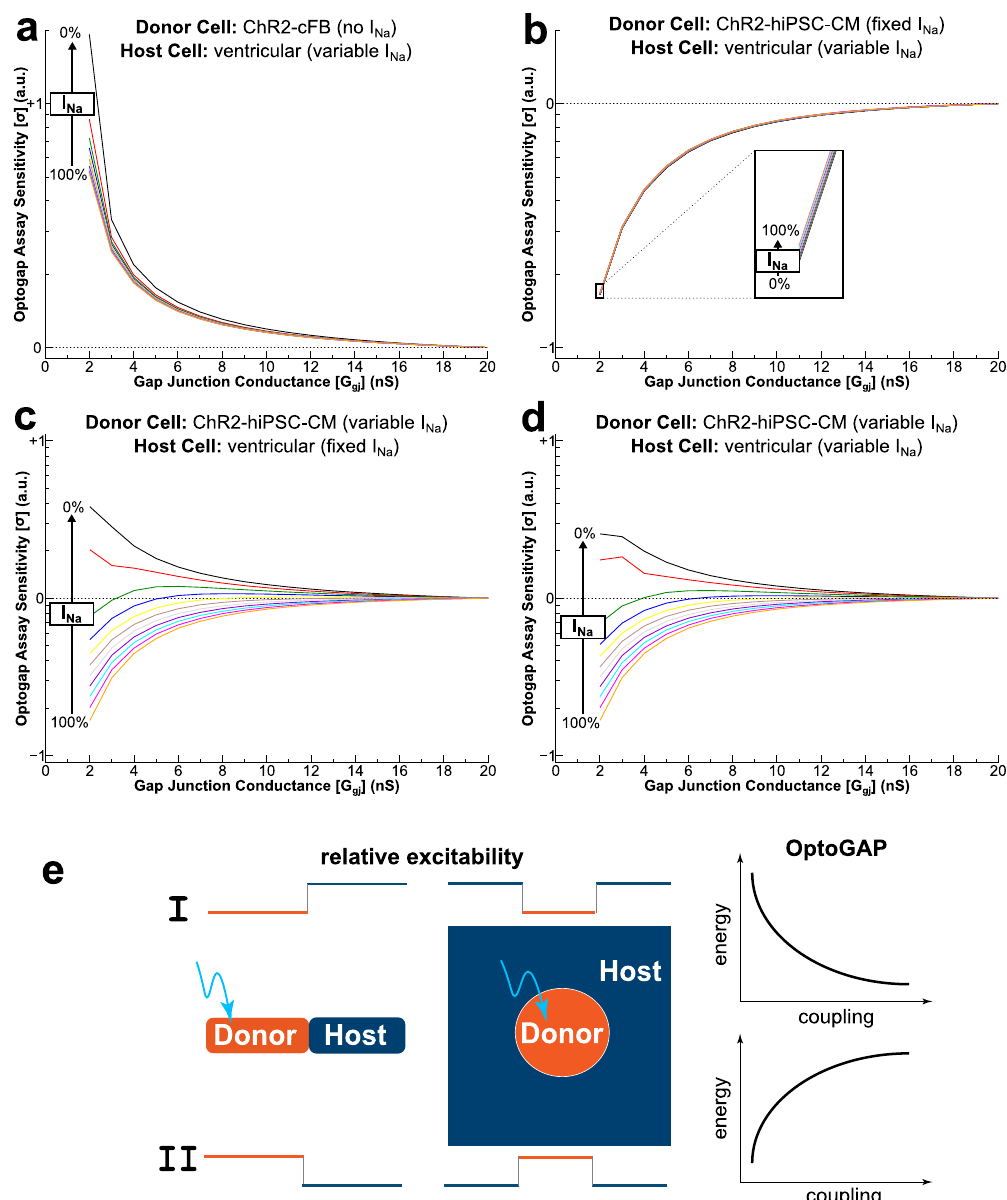
Figure 5. Generalizing OptoGap for different relative excitability between donor (D) and host (H) cells. ( a ) OptoGap assay sensitivity (σ) vs. inter-cellular gap junction conductance for tandem cell unit simulations in which the donor cell has relatively weak electrophysiological excitability (i.e., ChR2-cFB). See text for explanation of σ metric. Different-coloured lines show the same relationship but with gradually reduced host cell excitability (via I Na blockade). ( b ) Same as (a) but for donor cells with a higher baseline level of excitability (ChR2-hiPSC-CM); minor variation between curves. ( c ) Same as (b) but with gradually reduced donor cell excitability instead of host excitability. ( d ) Same as ( b ) but with both donor and host cell excitability reduced by the same amount for each line. ( e ) Conceptual schematics for different D/H configurations. I: When light-sensitive D-cells have lower excitability than the H-tissue (similar to the case of ChR2-cFB among non- transduced cardiomyocytes), the OptoGap test follows an exponentially decreasing curve of energy as function of cell–cell-coupling. Corresponds most closely to the orange line (100% I Na ) in panel ( a ). II: When light- sensitive D-cells have higher excitability than the H-tissue (similar to the case of cell delivery of ChR2-iPSC- cardiomyocytes into the adult myocardium), the OptoGap test follows an exponentially increasing curve of energy as function of cell–cell-coupling. Corresponds most closely to the orange line (100% I Na ) in panel ( b